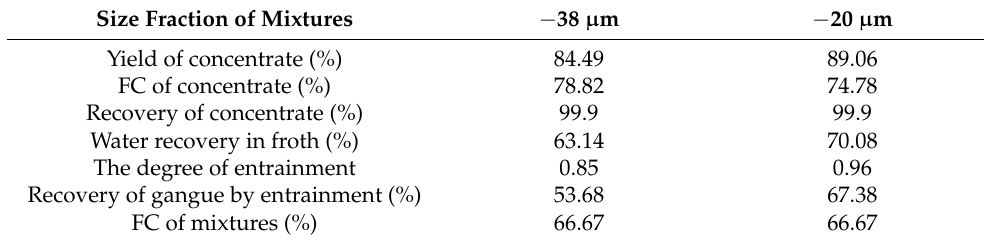
Table 2. Comparison of the flotation results of two artificial mixtures with the size fractions of − 38 µ m and − 20 µ m. Size Fraction of Mixtures − 38 µ